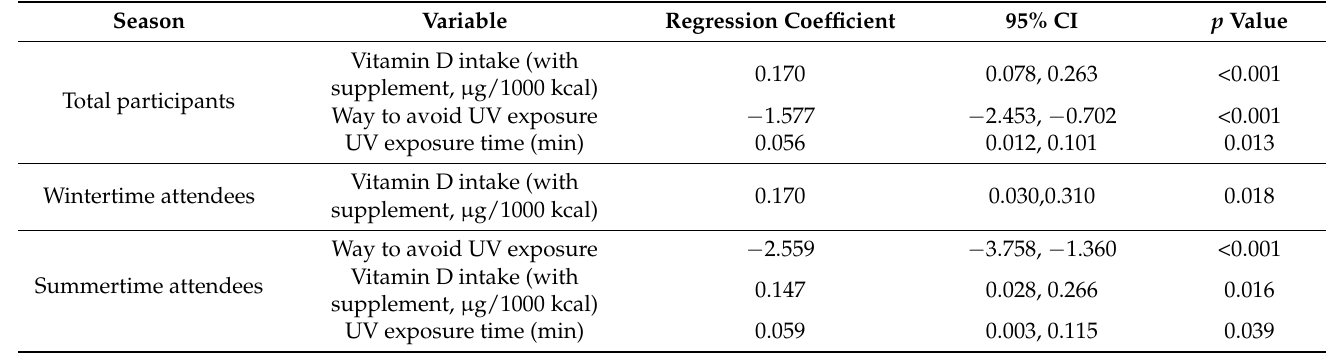
Table 3. Regression coefficients for the association between serum 25(OH)D levels and variables by